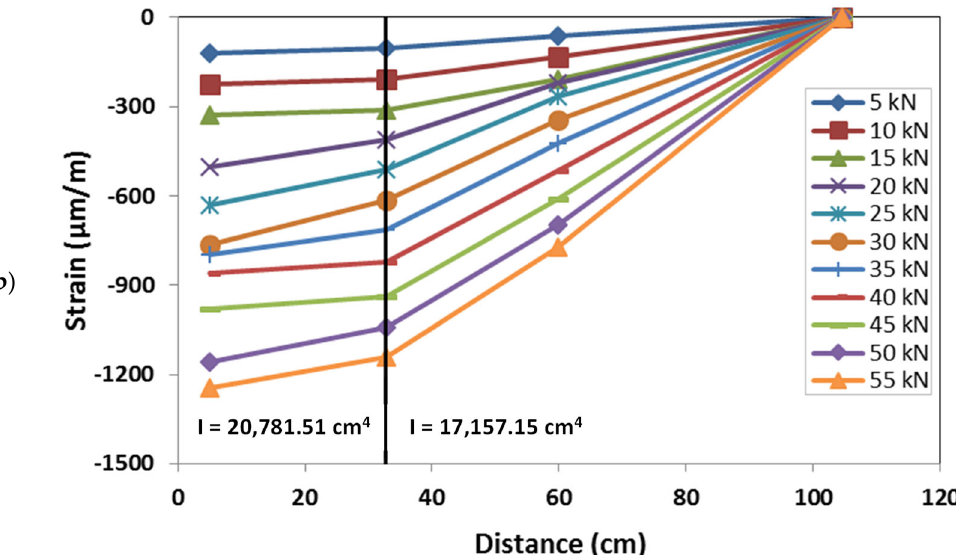
Figure 14. Strain distribution in the column flange at different loads: ( a ) pushing phase; ( b ) pulling phase.